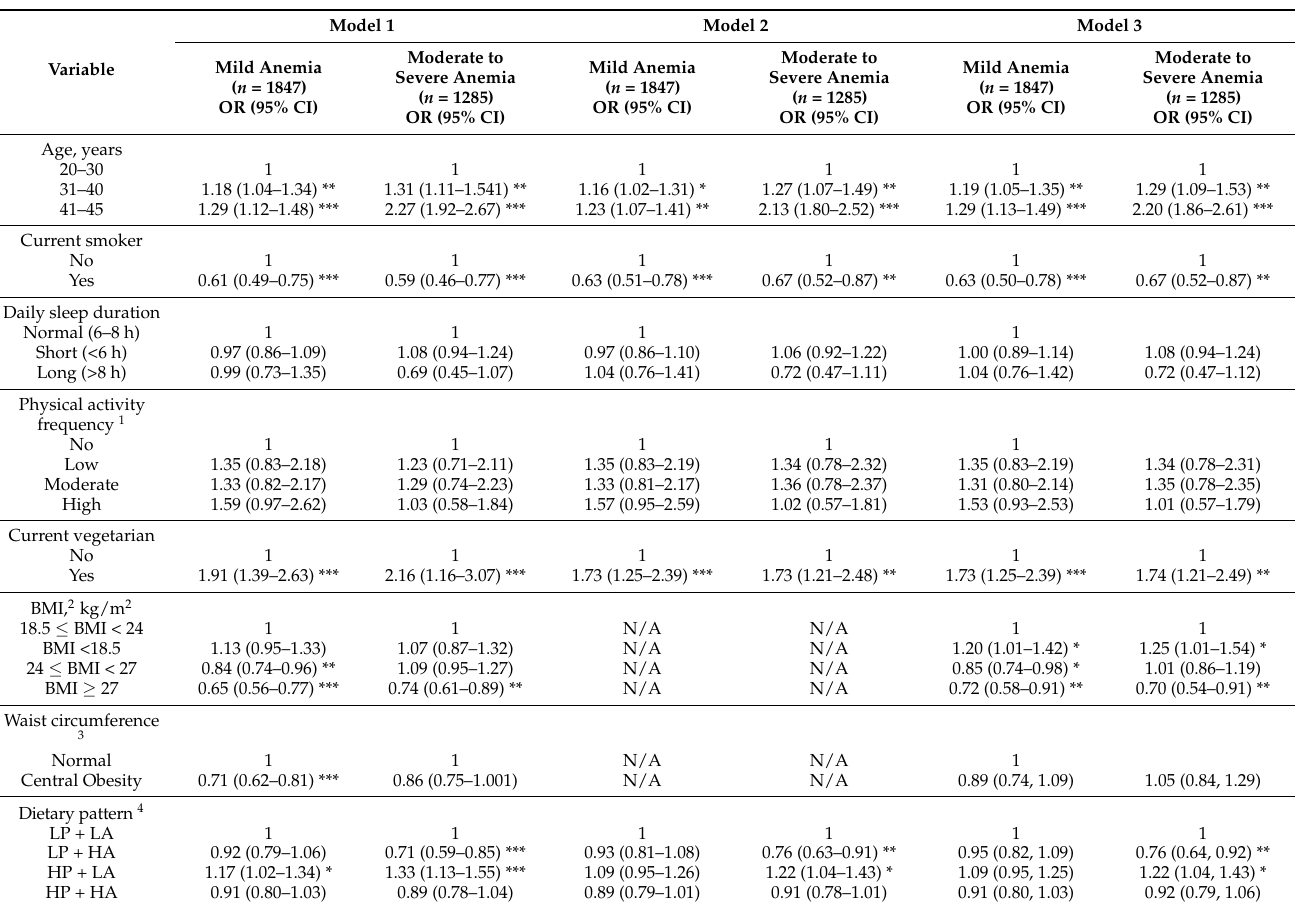
Table 3. Association between lifestyle, anthropometric, or dietary variables and mild or moderate